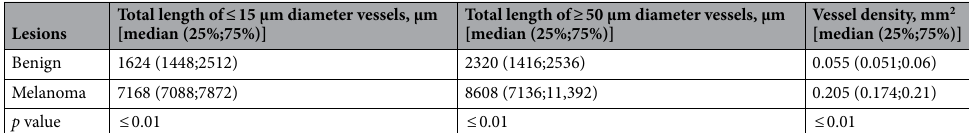
Table 2. OCA features of benign nevi (n = 10) and invasive melanomas (n = 21).